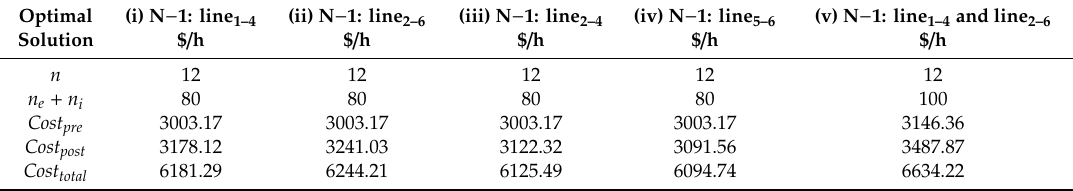
Table 4. Security-constrained operational cost considering the ranking of contingencies.